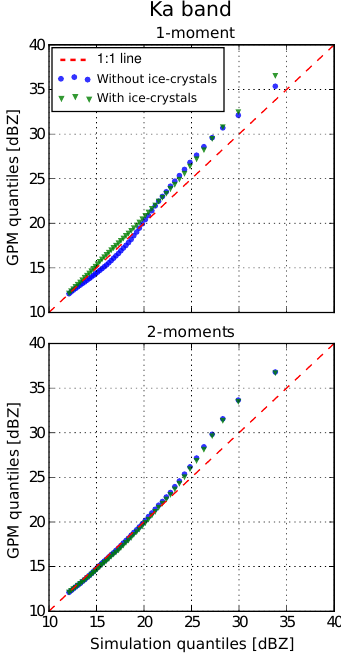
Figure 22. QQ-plots of the quantiles of simulated Z H values ver- sus the quantiles of observed GPM Z H values at Ka band. The red line corresponds to the 1 : 1 line indicating a perfect match with ob- served